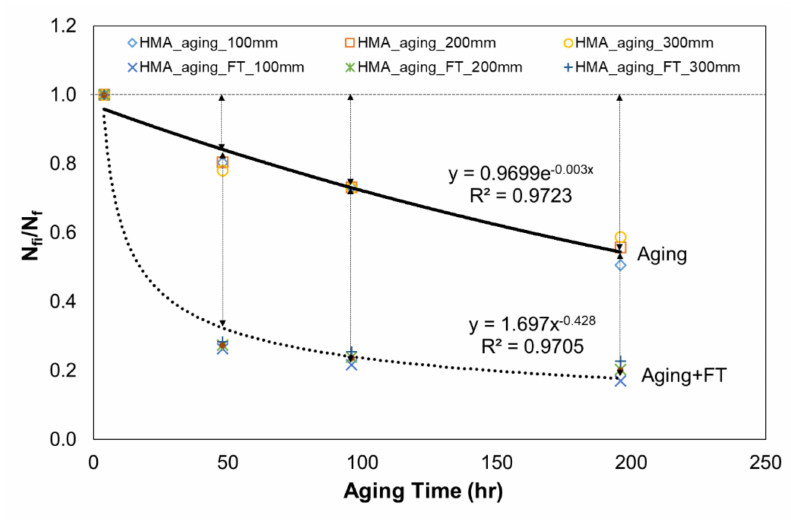
Figure 16. Analysis of fatigue effects after moisture damage for each stage of aging according to service period